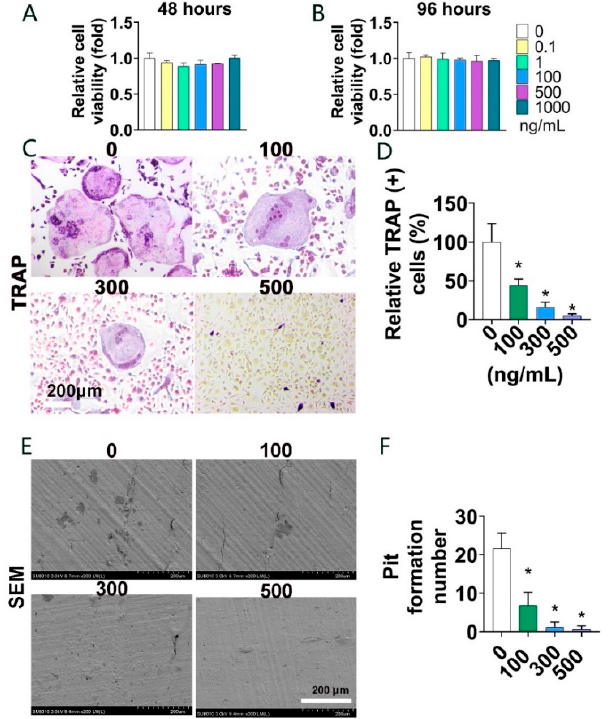
Figure 2. Parkin suppressed osteoclast formation in vitro. ( A , B ) CCK-8 assays showed no cytotoxic effect of Parkin (0–1000 ng/mL) on BMMs after treatment for 48 and 96 h. ( C , D ) BMMs were treated with RANKL (100 ng/mL) and M-CSF (30 ng/mL) in the presence of 0, 100, 300, and 500 ng/mL Parkin for 5 days. TRAP staining showed that Parkin reduced osteoclast number and size in a dose- dependent manner. Scale bars = 200 µ m. * p < 0.05 compared with the absence of Parkin (0 ng/mL). ( E , F ) Representative SEM (scanning electron microscopy) images showed that Parkin significantly reduced the size of resorption pits in a dose-dependent manner. BMMs were treated with RANKL (100 ng/mL) and M-CSF (30 ng/mL) in the presence of 0, 100, 300, and 500 ng/mL Parkin during osteoclast induction for 5 days. * p < 0.05 compared with the absence of Parkin (0 ng/mL). 3.3. Parkin Protein Inhibits Osteoclast-Specific Genes and F-Actin Ring Formation Specific genes during osteoclastic differentiation (ATPase, MMP9, NFATc1, and TRAP) protein levels in RANKL-induced osteoclasts were decreased by Parkin (300 ng/mL) on